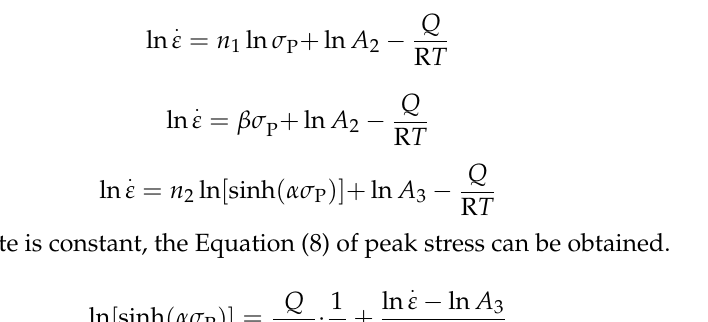
Table 2. Peak stress σ P under different deformation conditions (MPa). Strain Rate [s − 1 ]